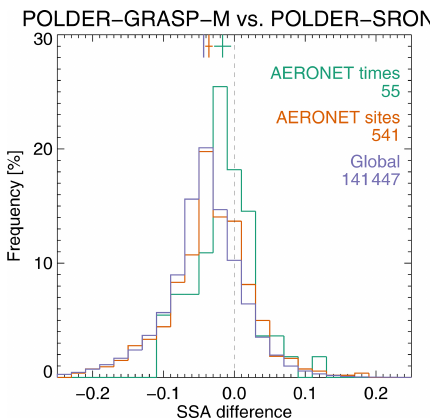
Figure 10. SSA differences POLDER-GRASP-M vs. POLDER- SRON for three different samplings: all available data, data avail- able over AERONET sites that provide Inversion L2.0 data, and data available at the times and locations of Inversion L2.0 data. The vertical coloured lines at the top show distribution means, and the short horizontal lines extending from the middle show 2 σ ranges. The dashed vertical line shows zero difference. The number of col- located data is indicated in the figure as well. This analysis suggests that an evaluation with AERONET would underestimate the actual difference between the two products. In all cases, data were collo- cated within 3h, and a minimum AOD > 0 . 25 was required.